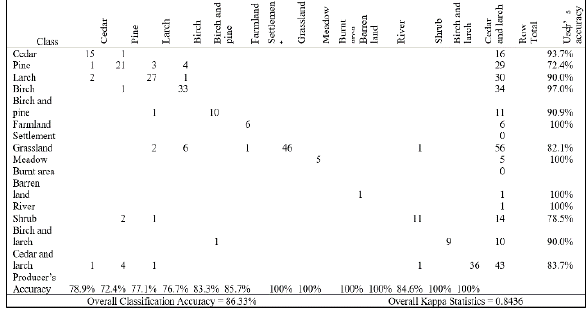
Table 4. Error matrix for the overall classification in